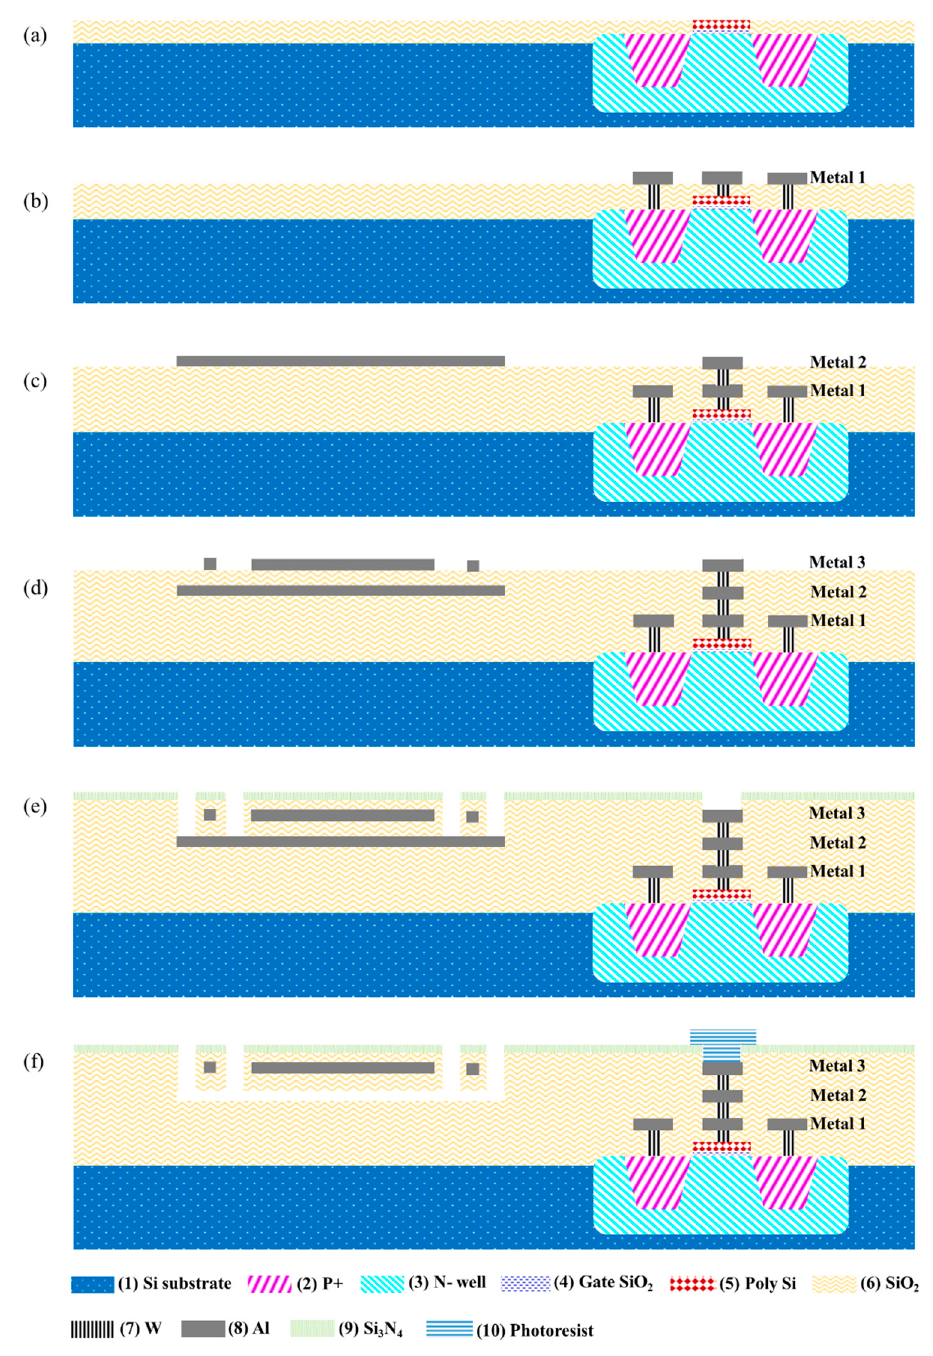
Figure 4. The process flow for an Al microbolometer: ( a – e ) are in a standard CMOS process and ( f ) is in a subtractive micro-electro-mechanical system (MEMS) process.